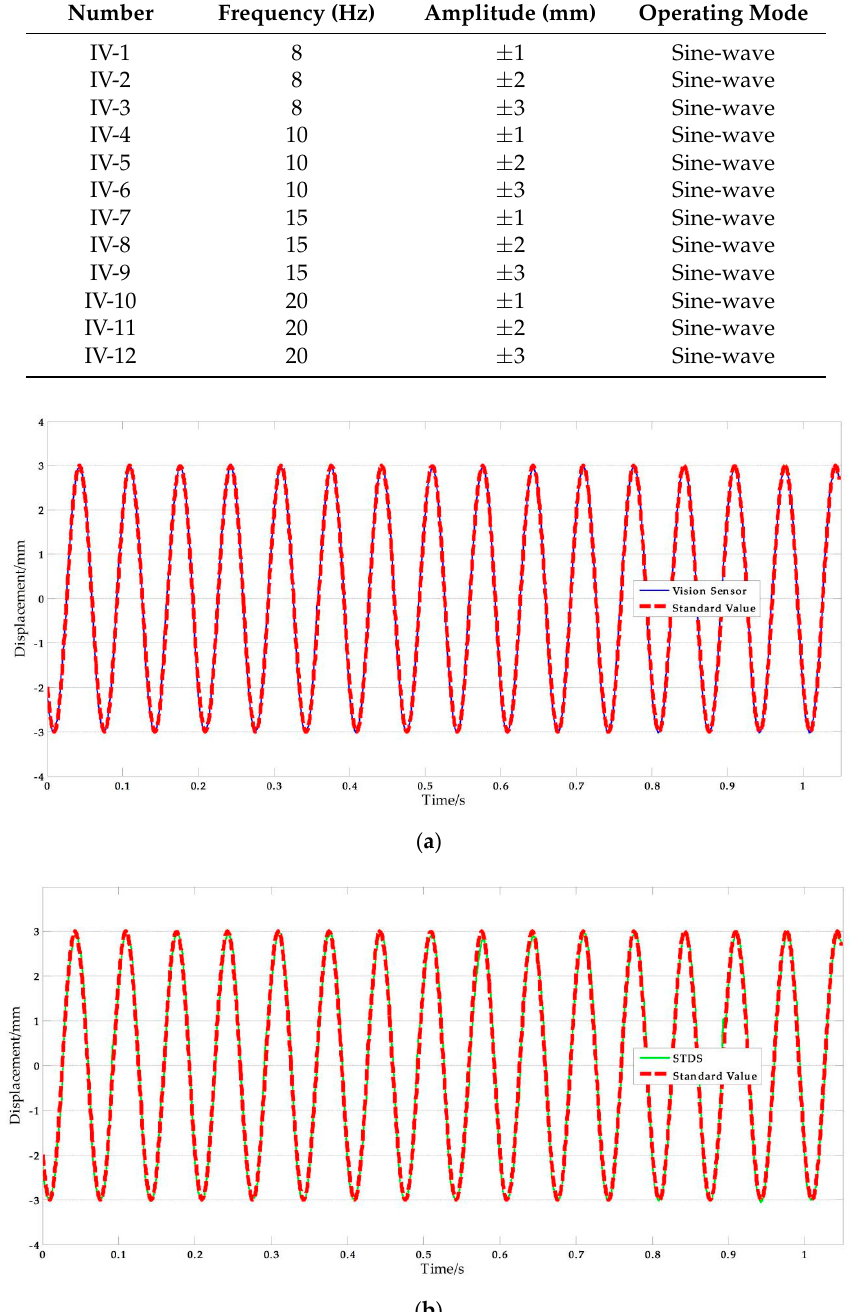
Table 12. Experimental parameters of shaking table tests.